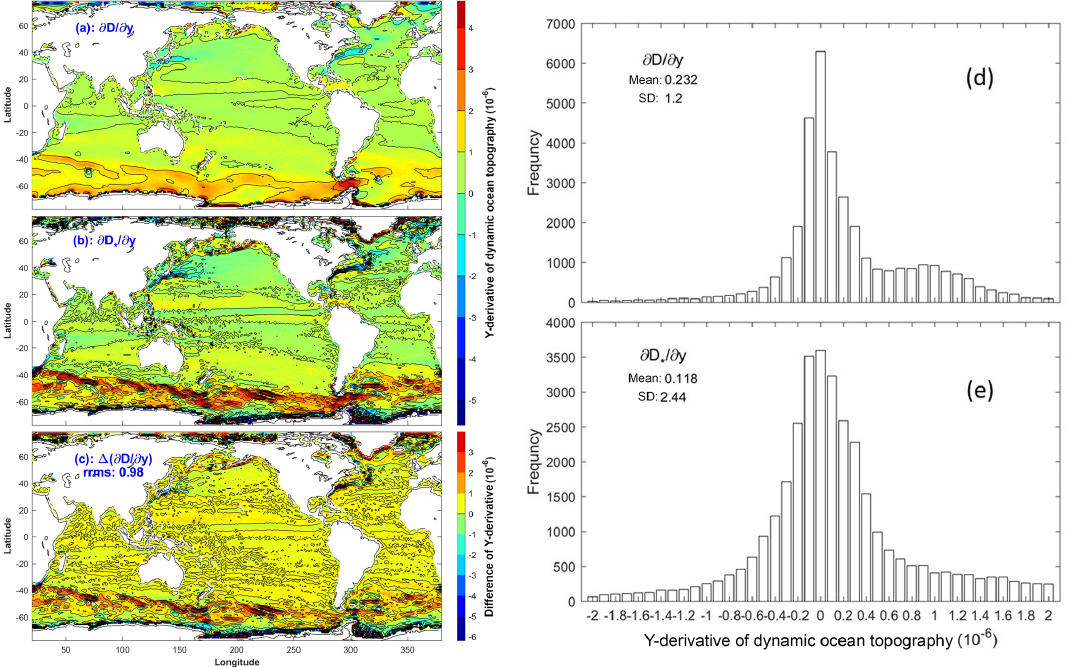
Figure 4. Derivatives in the y direction of (a) the first-type DOT (i.e., ∂D/∂y) , (b) the second-type MDOT (i.e., ∂D ∗ /∂y) , and (c) the difference (cid:49)(∂D/∂y) = ∂D ∗ /∂y − ∂D/∂y ; (d) histogram of global ∂D/∂y and (e) histogram of global ∂D ∗ /∂y